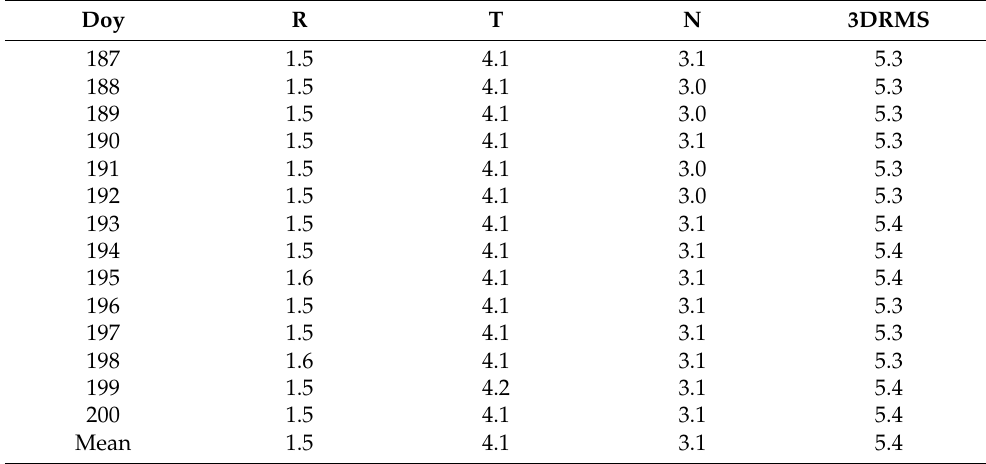
Table 6. The precision statistics of HY2D satellite using spaceborne BDS data (unit: cm).